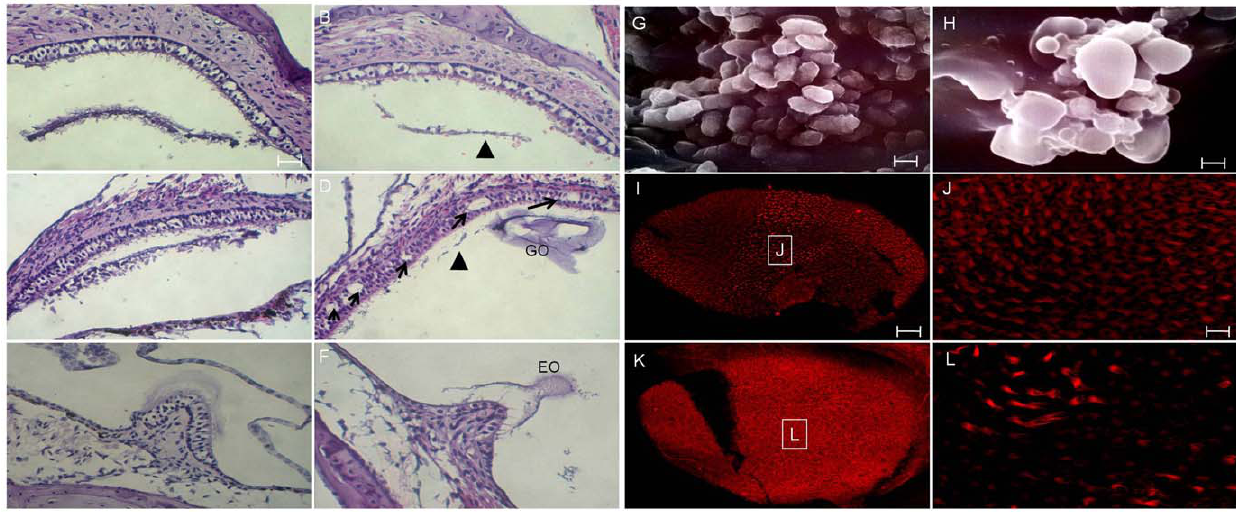
Figure 7. Comparison of vestibular morphology between Slc26a4 + / + mice (A, saccule; C, utricle; E, semicircular canal; G, utricular macula) and Slc26a4 tm1Dontuh/tm1Dontuh mice (B, saccule; D, utricle; F, semicircular canal; I, utricular macula). Slc26a4 tm1Dontuh/tm1Dontuh mice revealed a decreased amount of otoconia in the saccule and utricle (B & D, arrowhead), formation of ‘‘giant otoconia’’ in the utricle (D & H), ectopic otoconia in the semicircular canal (F), as well as a wide spectrum of vestibular hair cell loss and degeneration (arrows) at 8 weeks of age. Scanning electron microscopy reveals the markedly enlarged otoconia at saccule and utricle in Slc26a4 tm1Dontuh/tm1Dontuh mice (H) as compared with wild-type (G). Degeneration of vestibular hair cells in Slc26a4 tm1Dontuh/tm1Dontuh mice was also revealed by fluorescence confocal microscopy (L). J, L: magnification of boxes J and L from figures I and K, respectively. EO, ectopic otoconia; GO, giant otoconia. Bar=50 m m (A–F, I & K), and 10 m m (G, H, J & L).